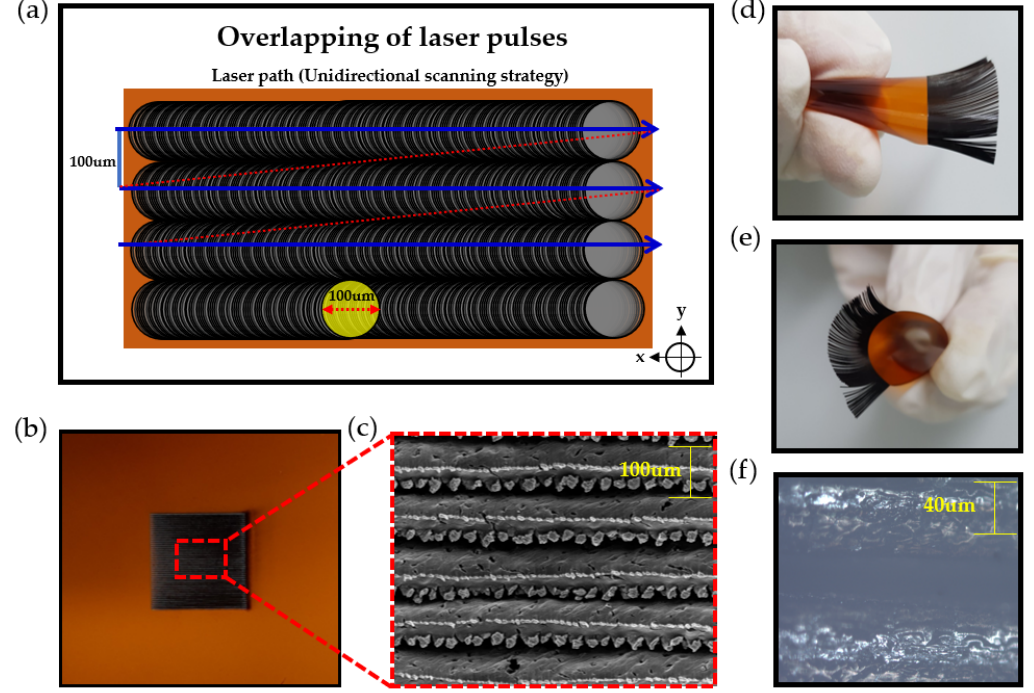
Figure 4. Fabrication and morphological characteristics of hair-like LIG patterns. ( a ) Schematic illustration of pulse overlap; ( b ) photograph of hair-like LIG patterns; ( c ) FE-SEM image of hair-like LIG patterns; ( d , e ) photograph of hair-like LIG patterns in a curved state; and ( f ) optical image of LIG patterns.